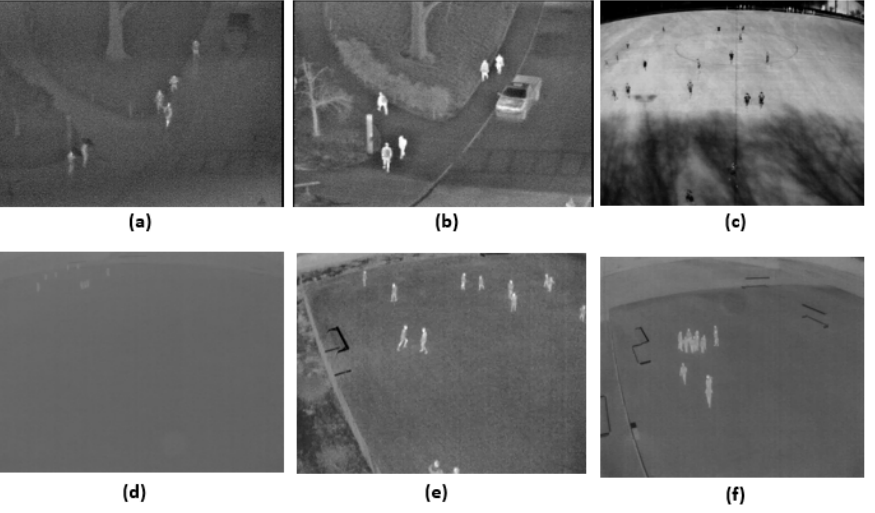
Figure 1. Sample thermal images from ( a , b ) OSU thermal dataset and ( c – f ) AAU PD T